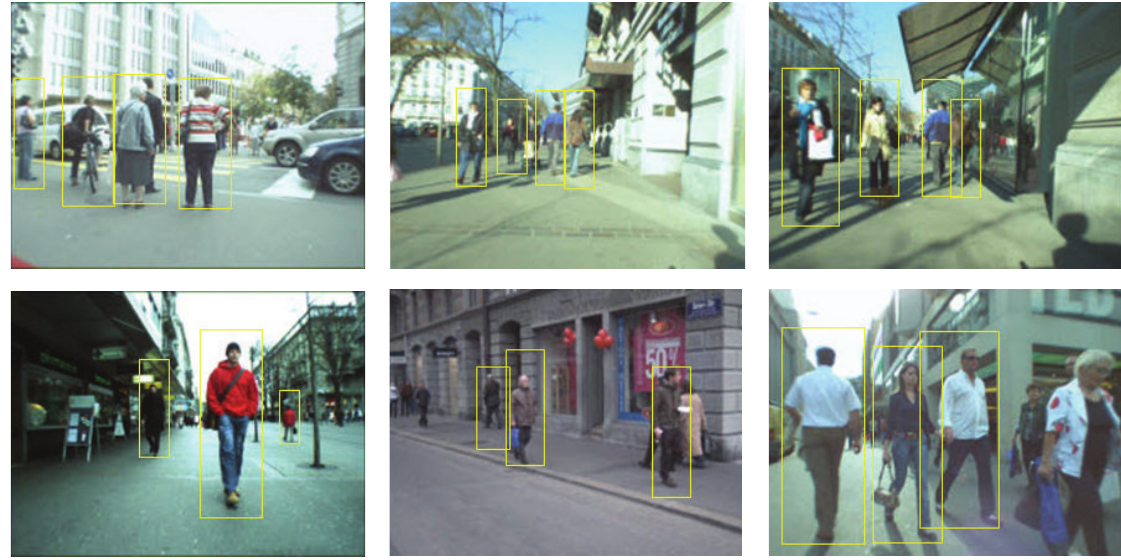
Figure 7: Successful moving objects detection results.